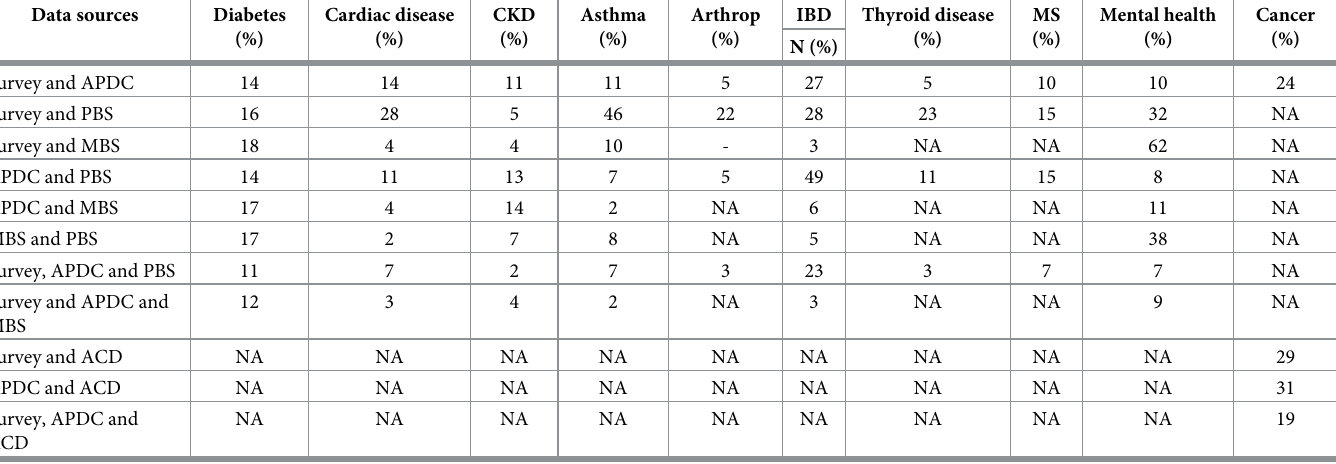
Table 3. Concordance between data sources for case ascertainment of ten chronic disease conditions by June 2020 among younger Australian women across their reproductive years a . Data sources